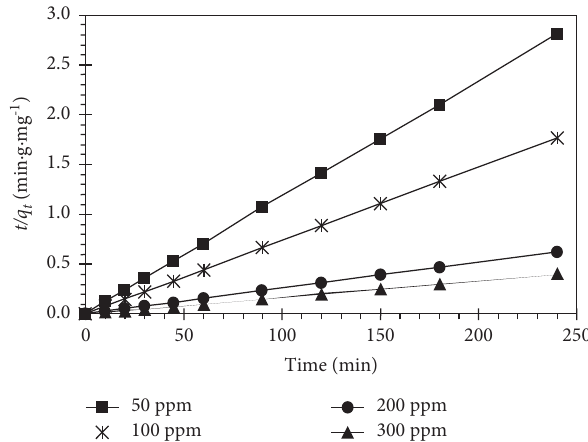
Figure 5: Pseudo-second-order kinetic Table 1: Kinetic parameters for the adsorption of CR onto FBP surface. C in (mg · L − 1 )